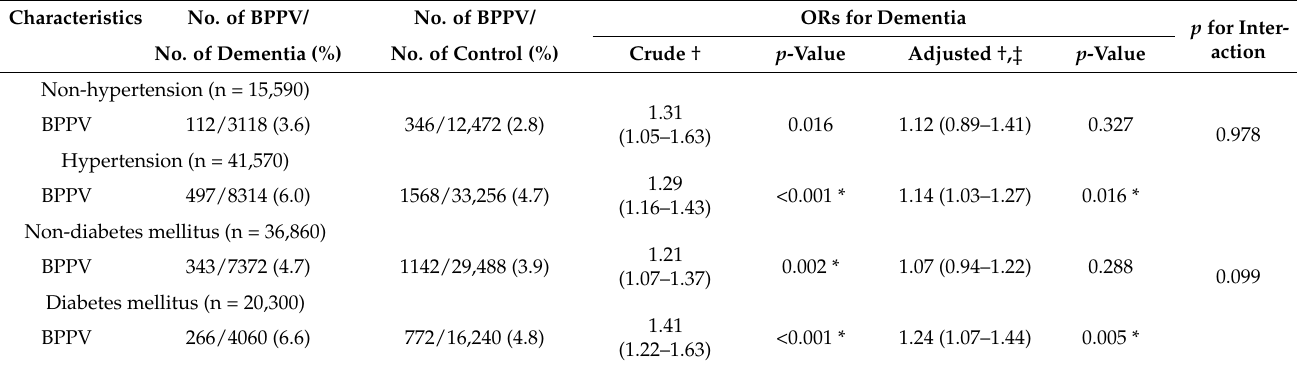
Table 3. Subgroup analysis of crude and adjusted odds ratios (95% confidence interval) of BPPV for dementia according to hypertension, diabetes mellitus, dyslipidemia, ischemic heart disease, cerebral stroke, Meniere’s disease, and head trauma.